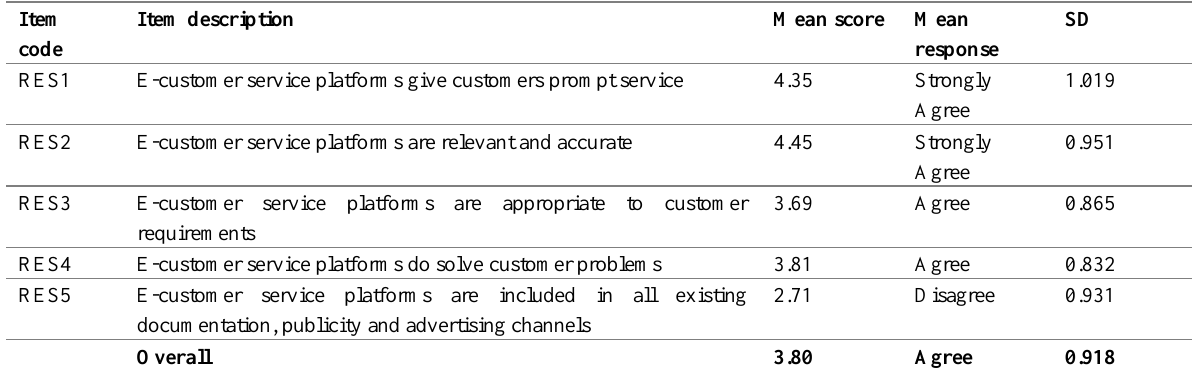
Table 4: Descriptive Statistics for Responsiveness